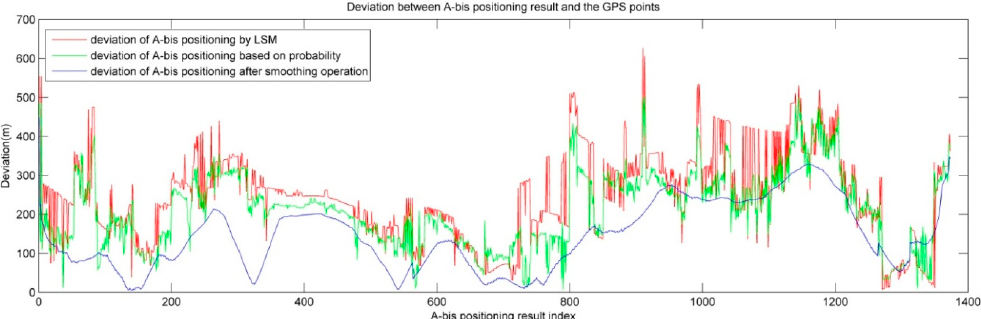
Figure 12. Deviation between A-bis positioning result and the GPS points.